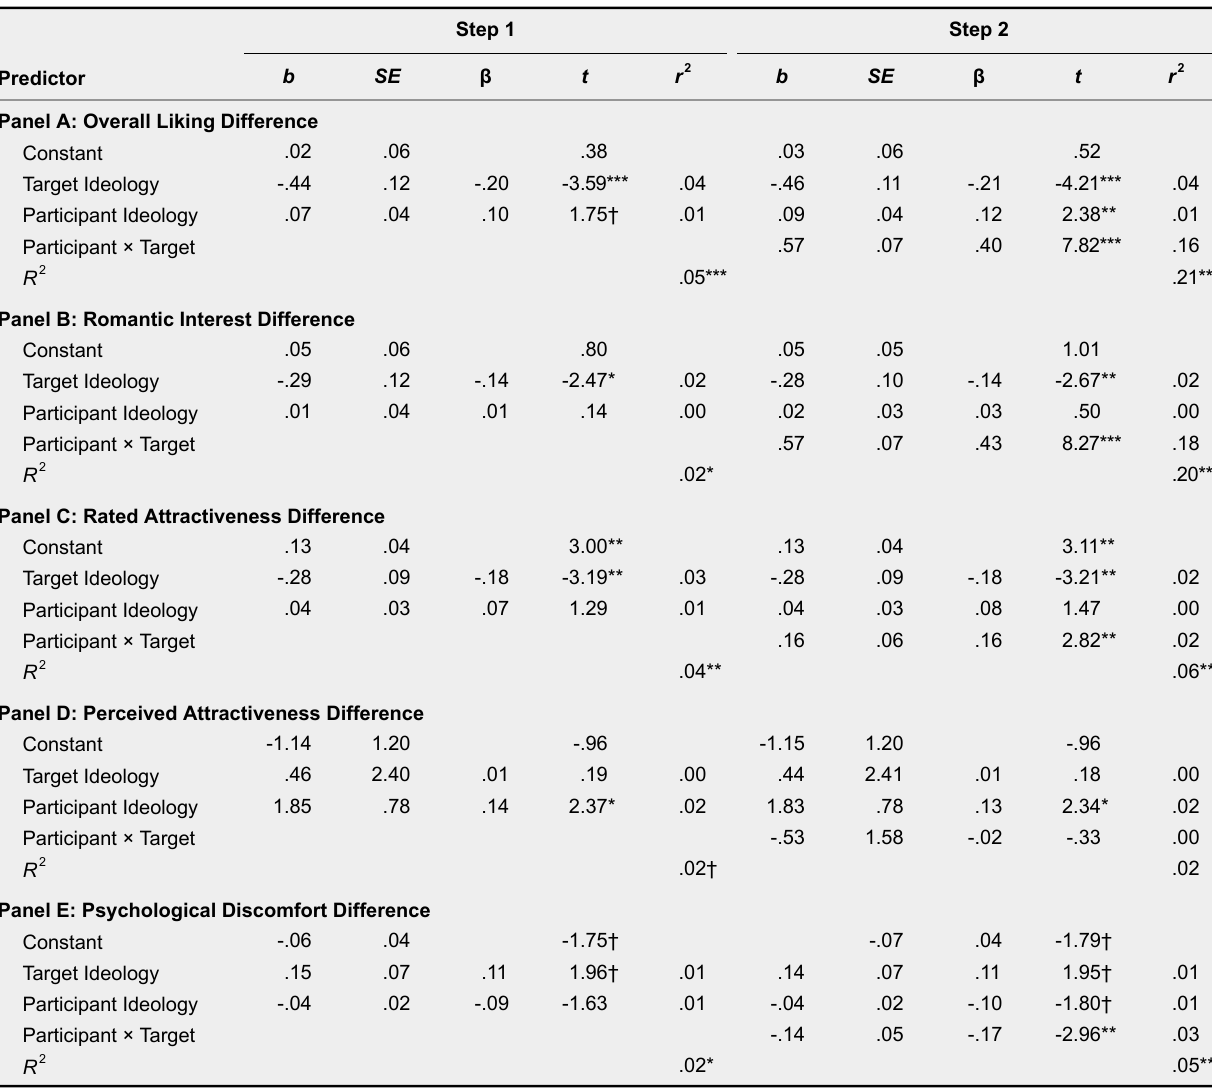
Study 2: Results of Moderated Multiple Regression Analyses for Dependent Variables With Semi-Partial r